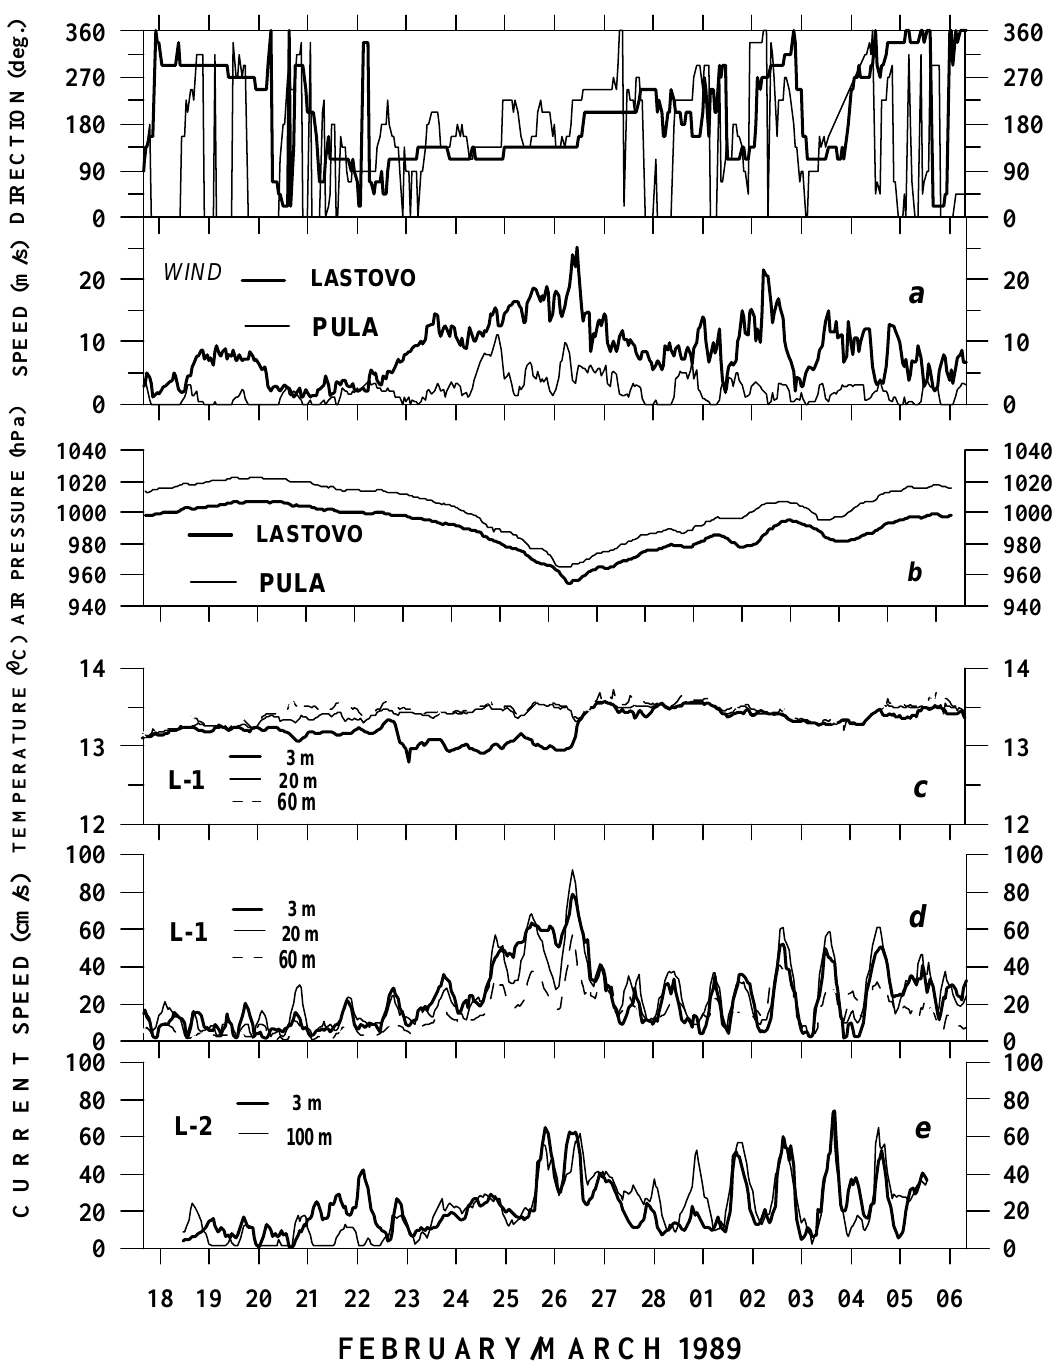
Fig. 3. Time series of hourly (a) wind speed and direction at Pula and Lastovo, (b) air pressure at Pula and Lastovo, (c) sea temperature at station L-1, (d) current speed at station L-1 and (e) current speed at station